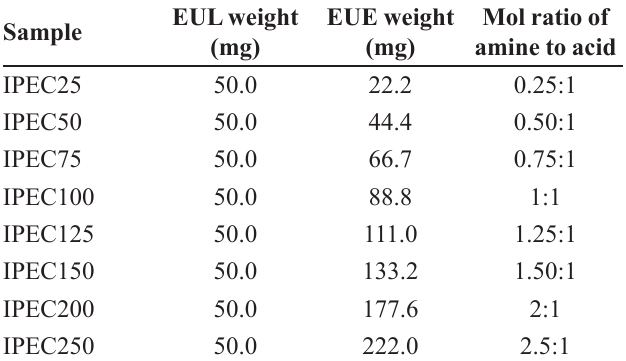
TABLE I - Interpolyelectrolyte compositions